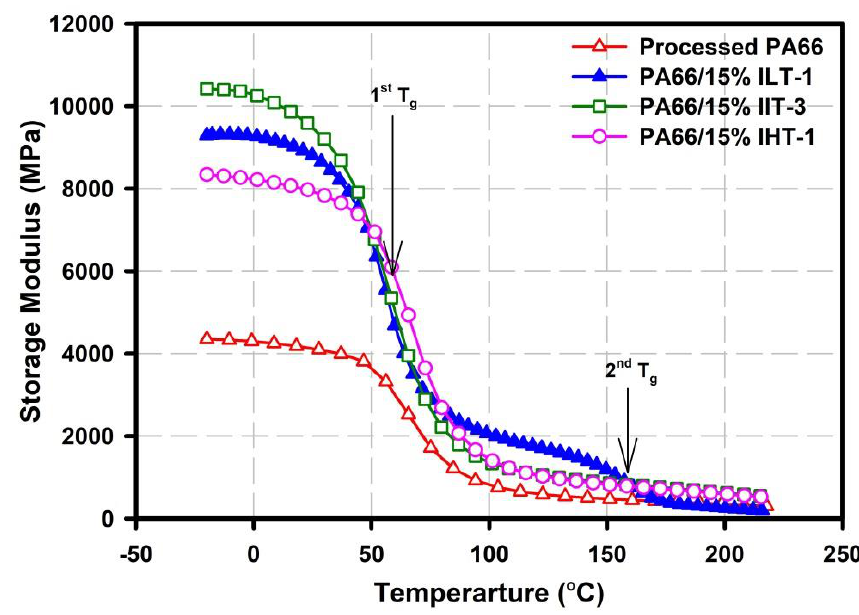
Figure 3. Storage modulus curves as a function of temperature for the studied PA66 / P-glass systems and processed virgin